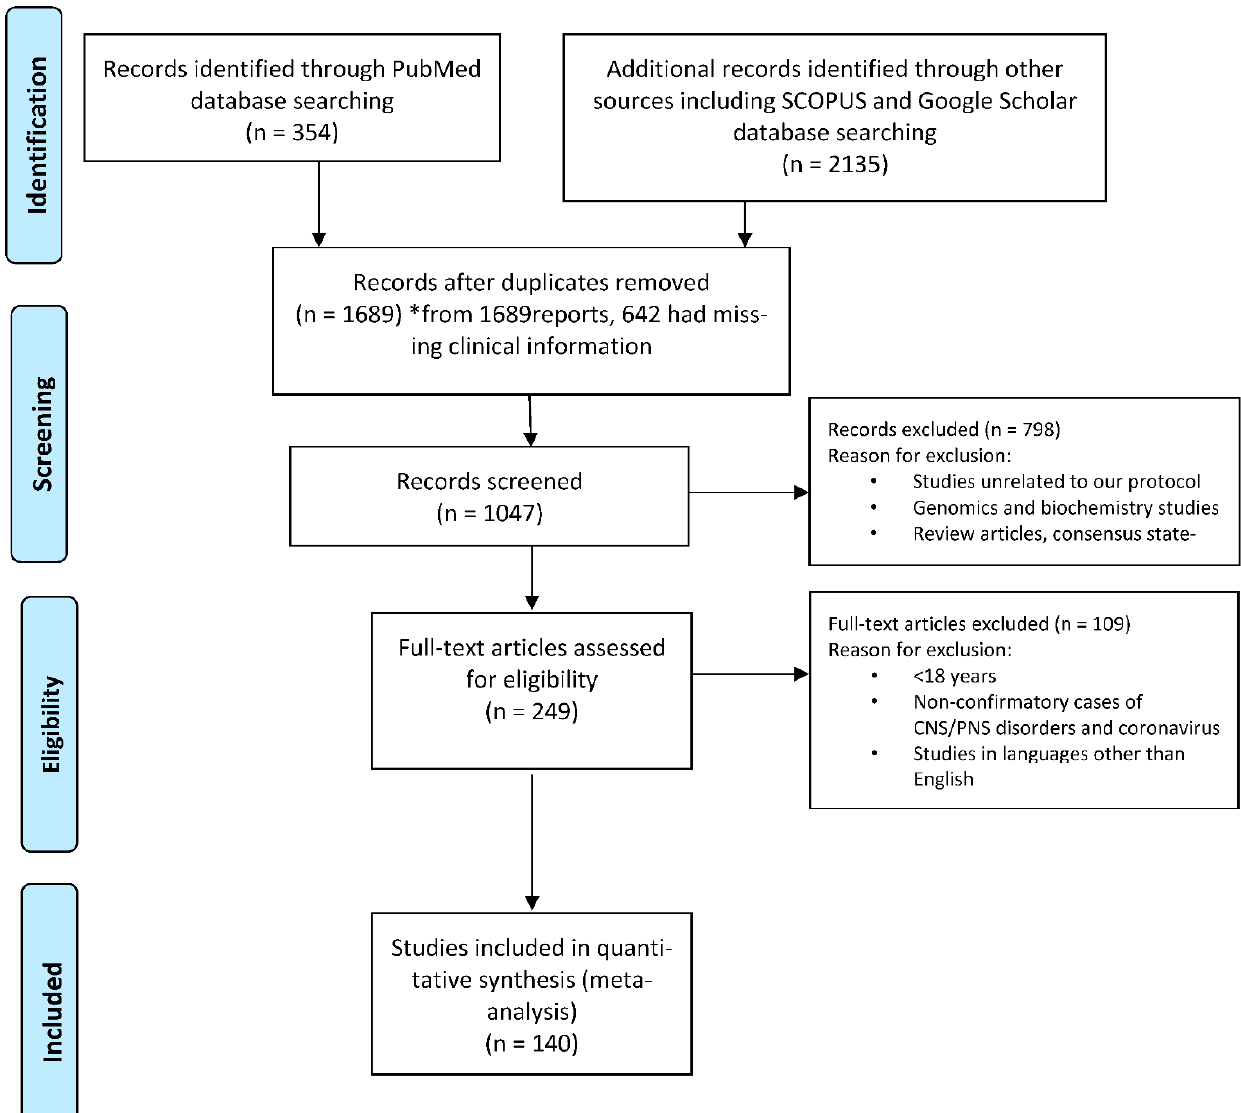
Figure 1. Preferred reporting items for systematic reviews and meta-analyses (PRISMA) flow diagram. * 642 missing data.